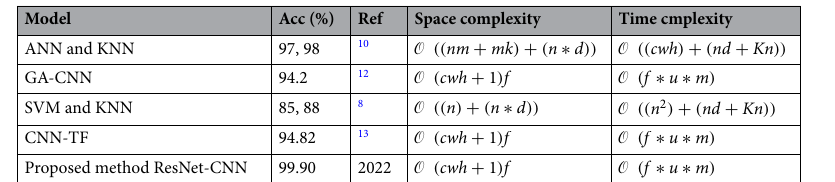
Table 6. Comparison of ResNet-CNN model accuracy with previous models. c = the number of convolutional channels, h = height of input, w = width of input, f = the convolutional kernel size, n = the number data instances, k = the number of output neurons, m = the number of input neurons and d = the dimension or feature of the input, K = number of nearest neighbors, u = c ∗ w ∗ h .